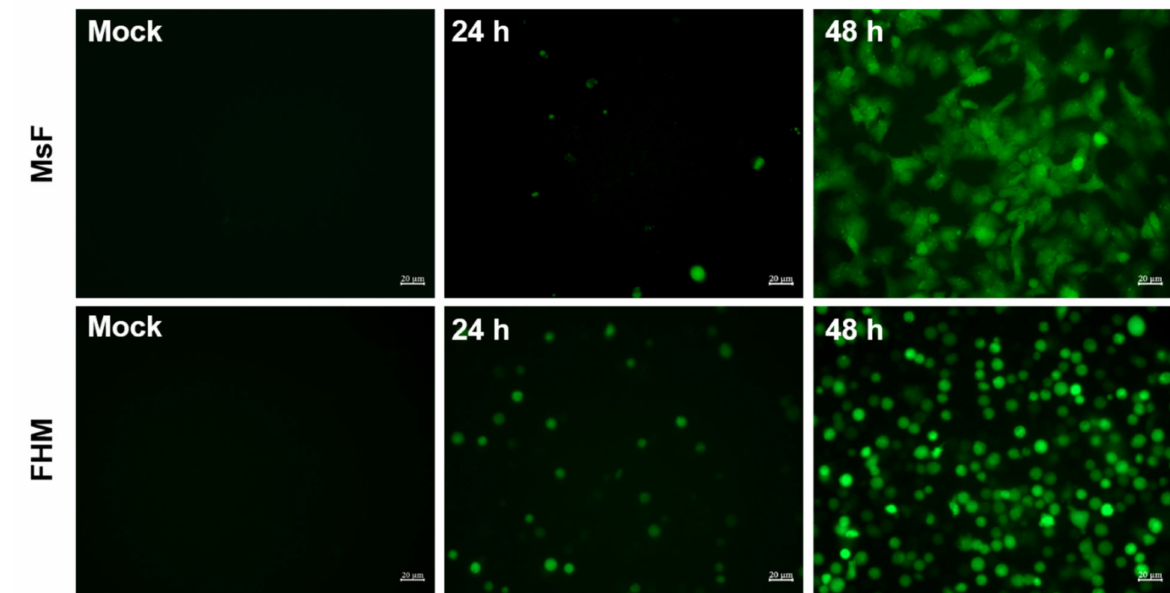
Figure 8. LMBV infection induced ROS generation in MsF cells or FHM cells. After staining with CM-H2DCFDA, mock- or LMBV-infected cells were observed under fluorescence